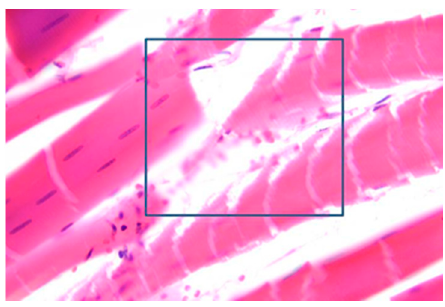
Figure 5. Tetanization-induced rhabdomyolysis. Fragmented striated muscle fibers with necrosis and erythrocytes (blue box indicates the detail) (H&E stain ×63).